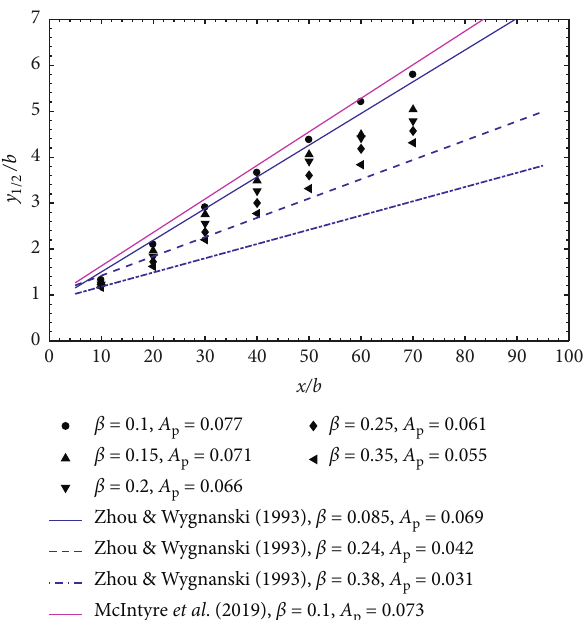
Figure 12: Streamwise development of y